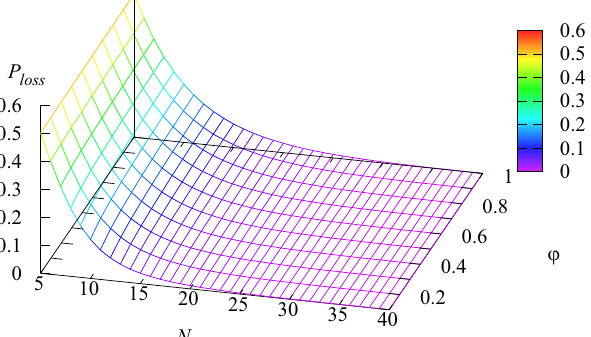
Figure 8. Dependence of the loss probability P loss and N .